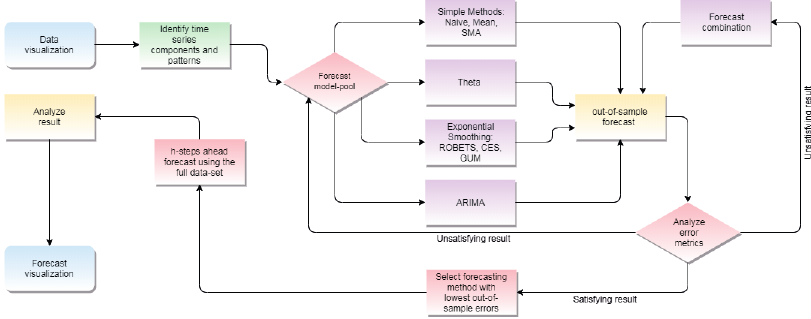
Figure 1. Forecasting fl owchart